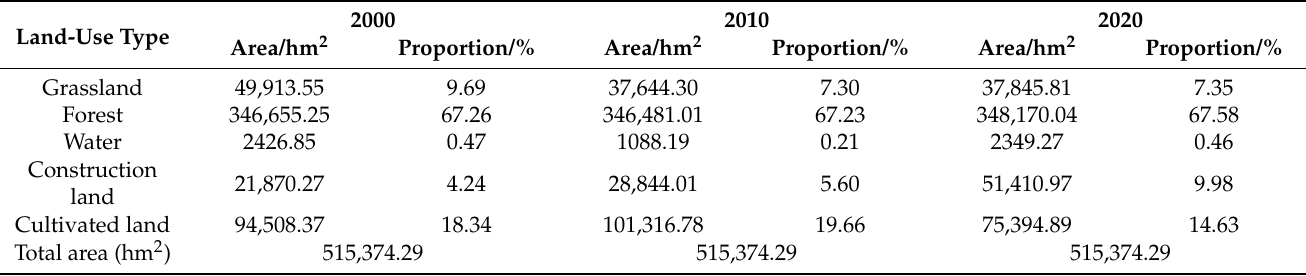
Table 4. The area of land-use type in the ECA in western Beijing from 2000 to 2020 (unit: hm 2